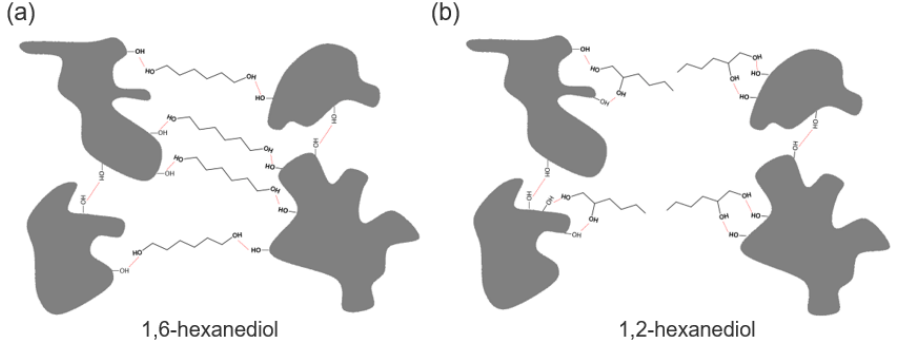
Figure 6. Schematic drawing of interaction between ( a ) 1,6-hexanediol and extract particle; ( b ) 1,2-hexanediol and extract particle (dimensions are not to scale).